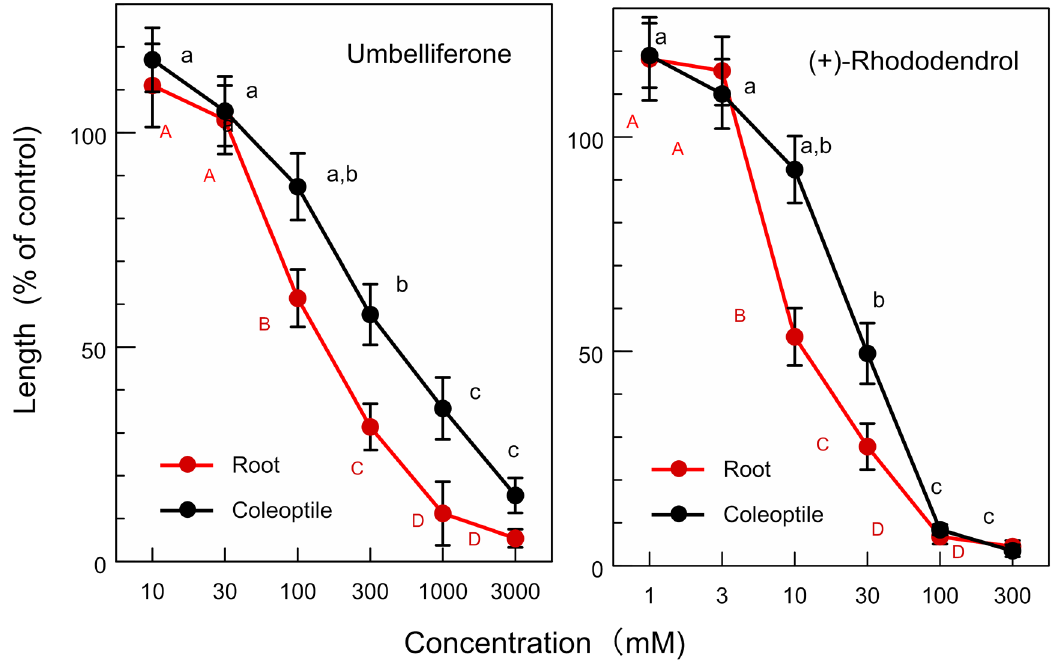
Figure 5. Effects of umbelliferone and (+)-rhododendrol on root and coleoptile growth of V. myuros. Means ± SE from 3 independent experiments with 10 seedlings for each determination are shown. Different letters on the symbols in the same panels indicate significant differences (Tukey’s HSD test, p ≤ 0.05).